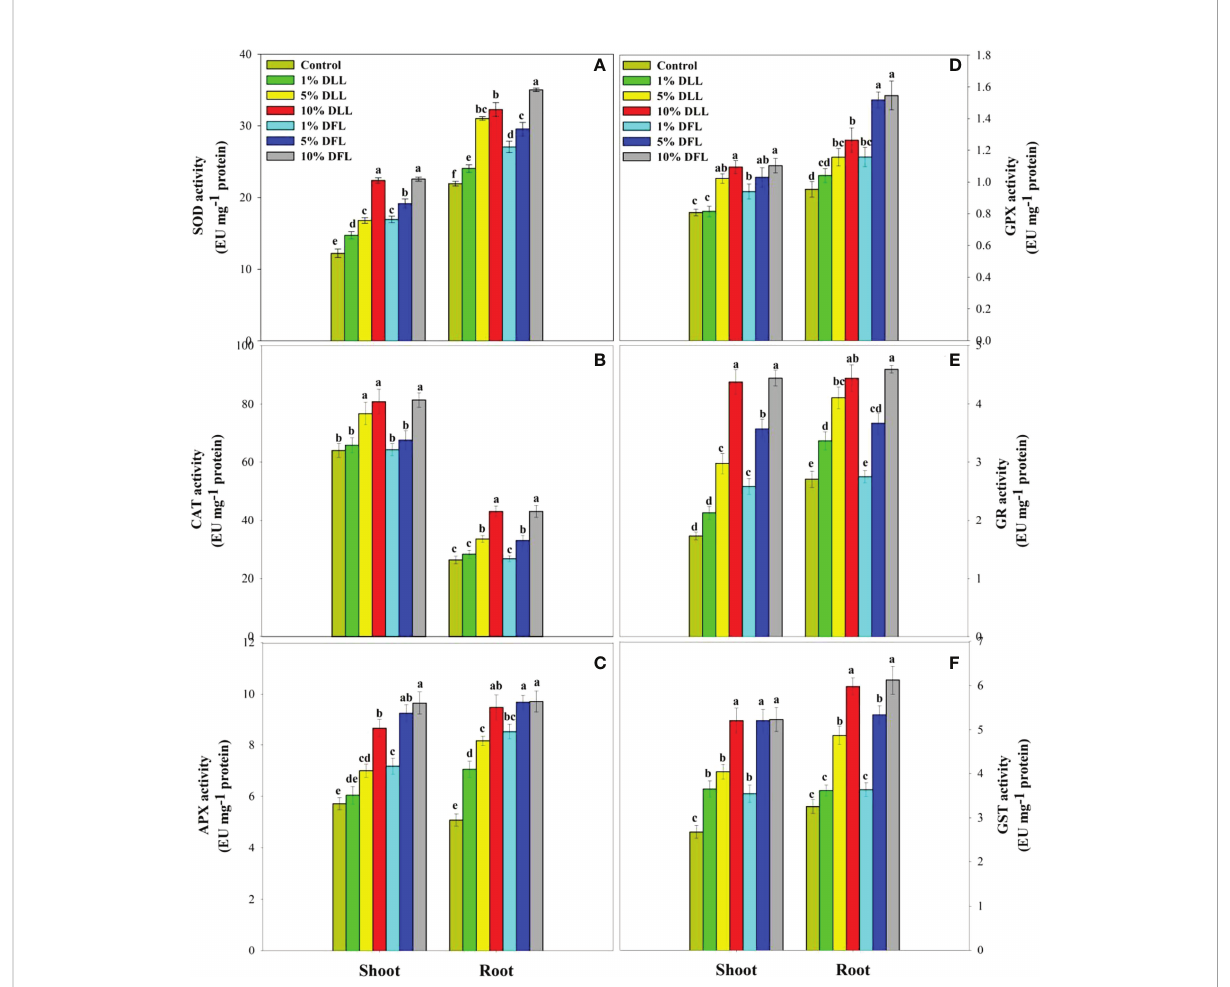
FIGURE 5 Superoxide dismutase, catalase, ascorbate peroxidase, guaiacol peroxidase, glutathione reductase, and glutathione S-transferase (EU mg -1 protein) activity (A – F) in Triticum aestivum L. seedlings (7 DAS) treated with leachates of dry leaves and fl owers of Tagetes erecta L. Data followed by the same letters are not signi fi cantly different at p<